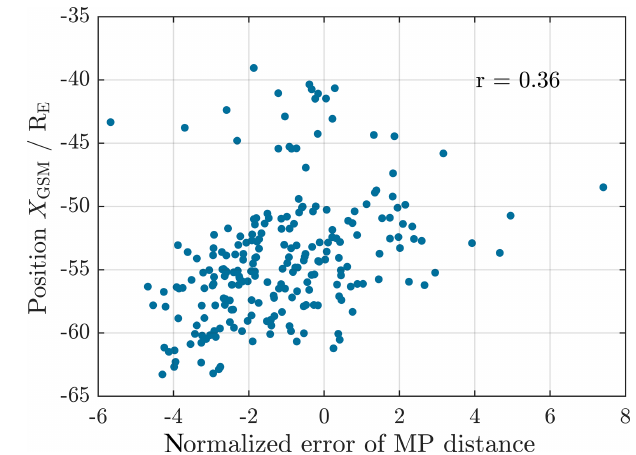
Figure 6. Example for non-existent correlation between the normal- ized MP distance and the position of the MP crossing projected onto the x GSM axis for innermost crossings. The correlation coefficient is only r = 0 . 36.